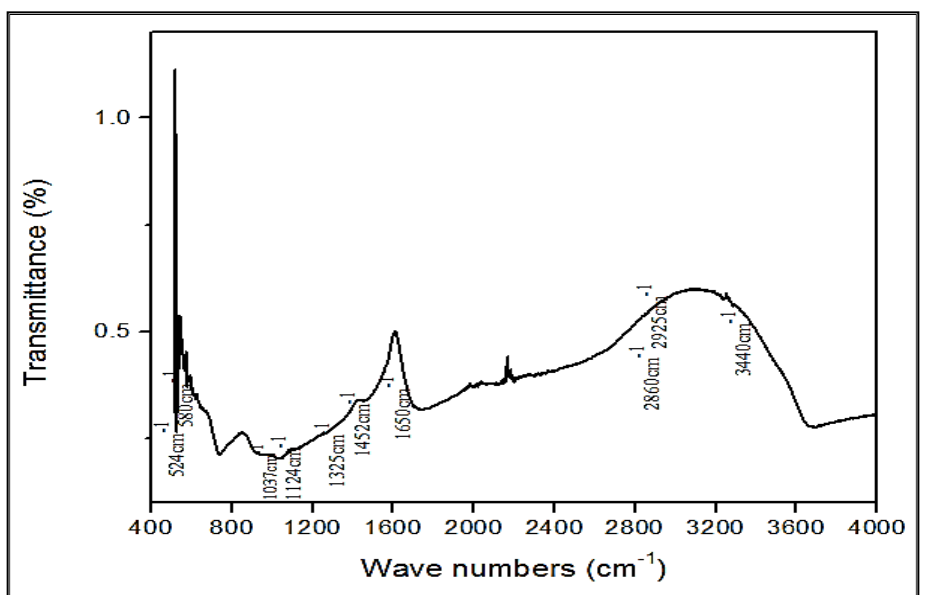
Figure 7. XRD patterns of the MB-ZnO nanocomposite.